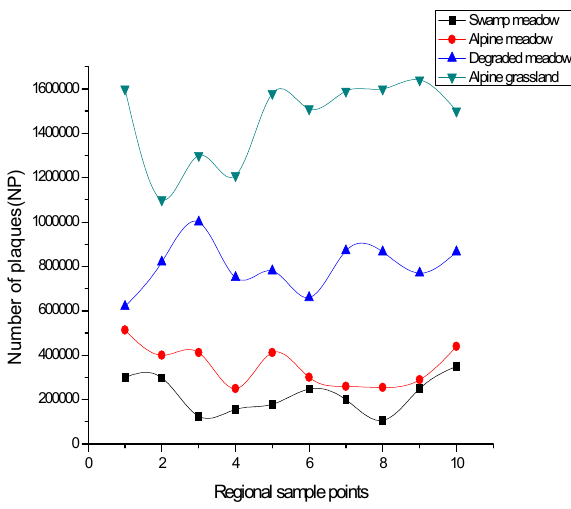
Figure 3. Curves of the number of patches of sample points in each region of the four grassland types